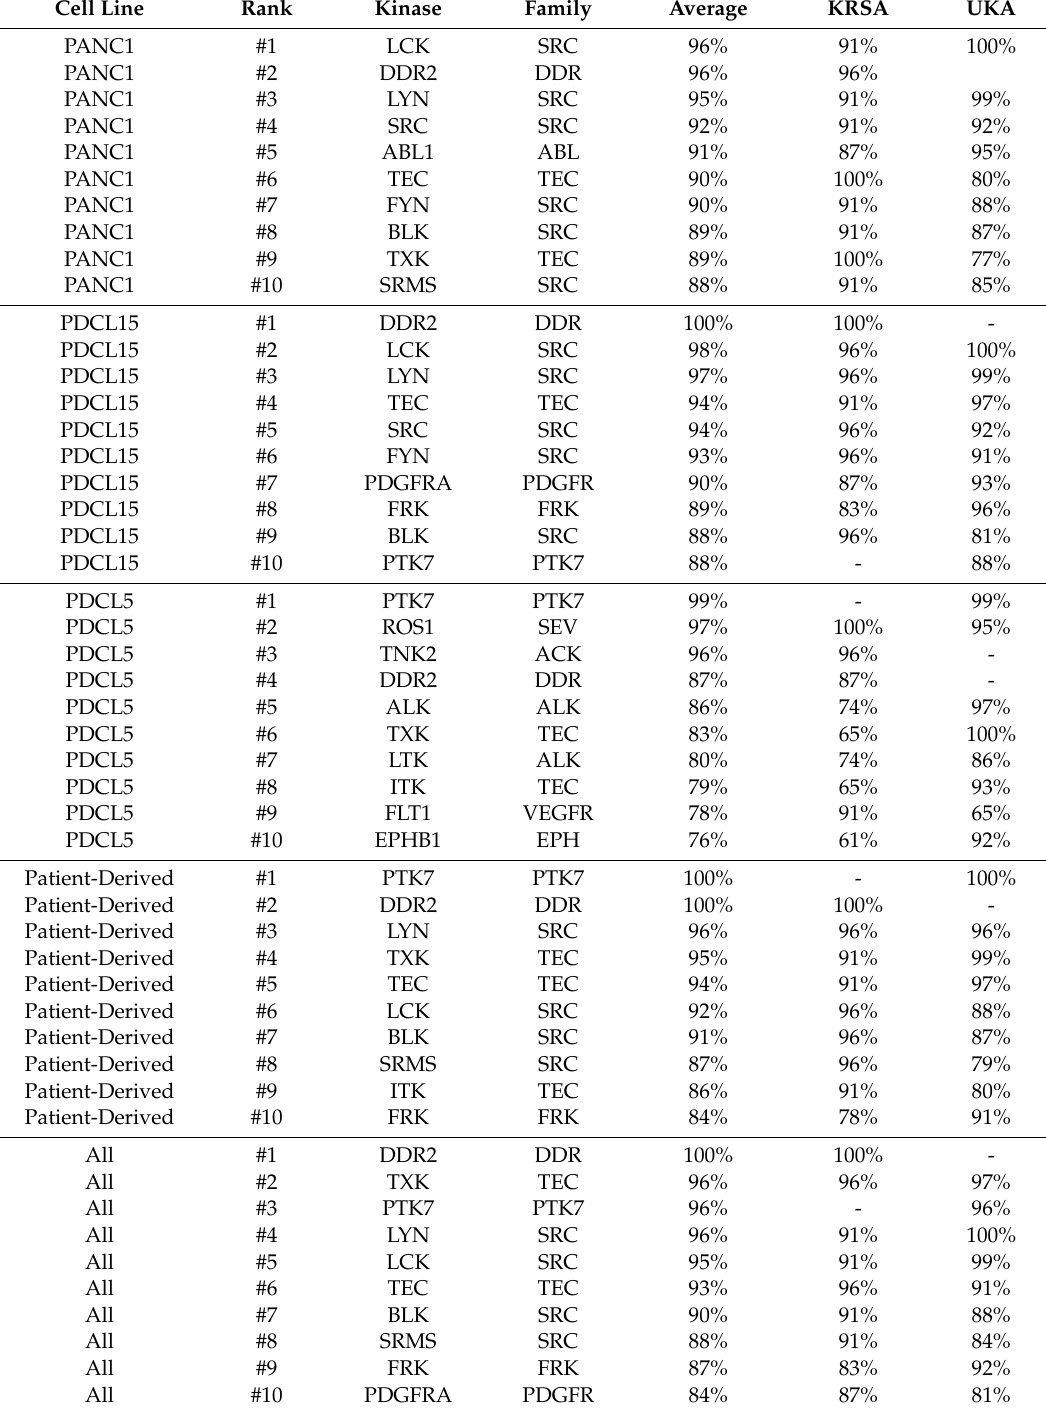
Table 1. UKA and KRSA average percentile